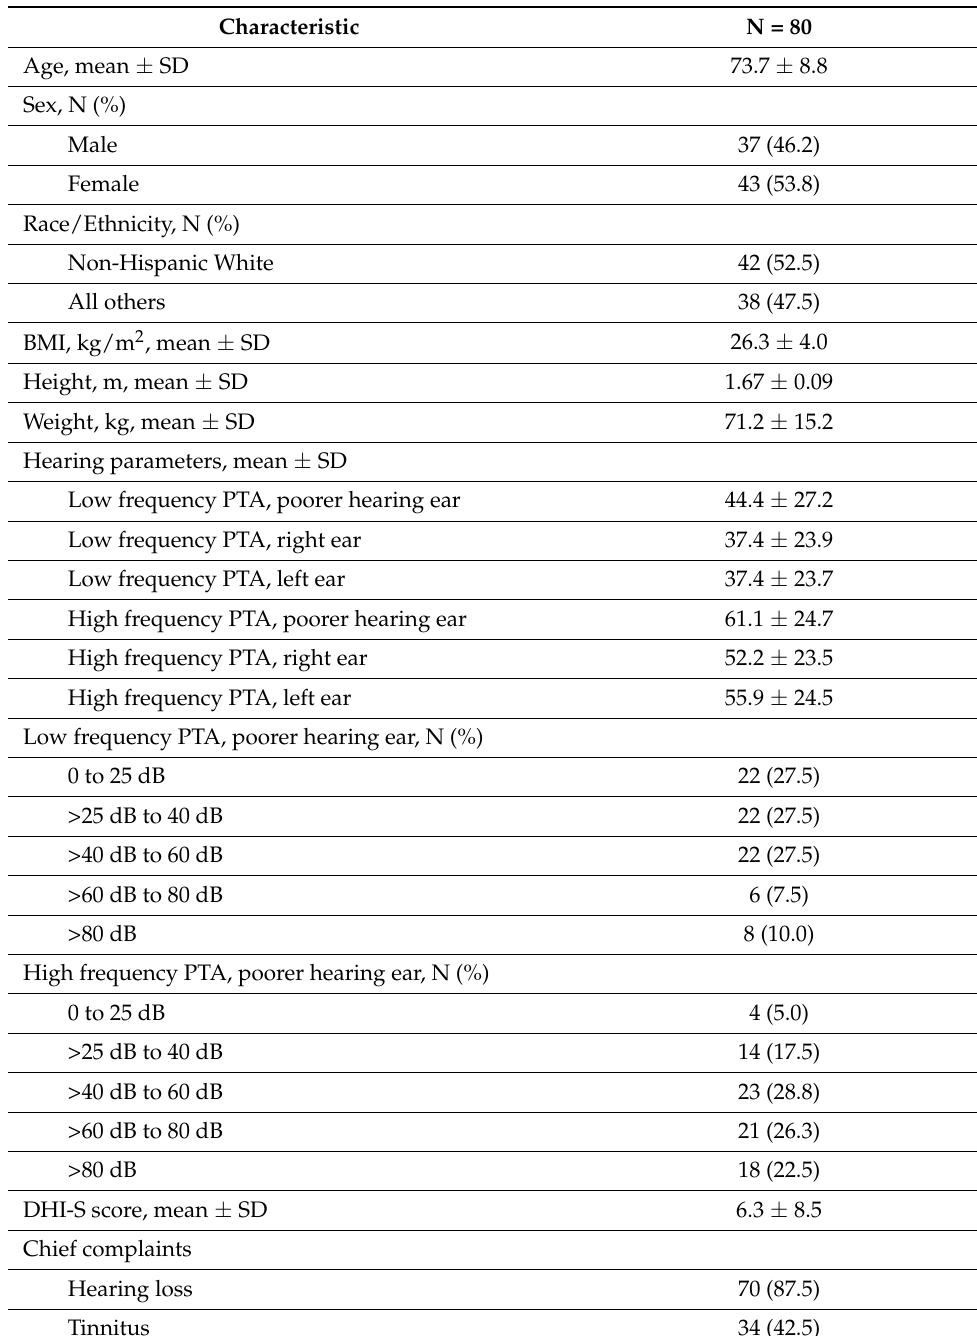
Table 1. Demographic characteristics of study